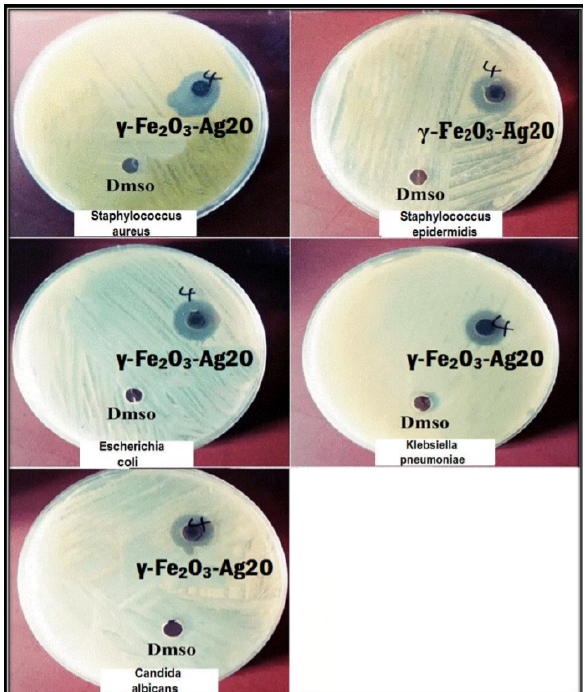
Figure 6: The antibacterial activity of 𝛾 -Fe 2 O 3 -Ag 2 O nanocomposite against (A)Staphylococcus aureus, (B) Staphylococcus epidermidis, (C) Escherichia coli , (D) Klebsiella pneumonia and (E) Candida